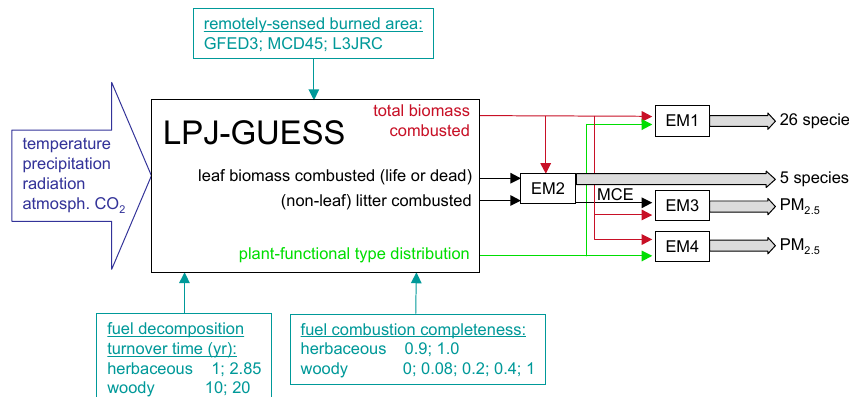
Fig. 1. Flow of information used for the sensitivity analysis (thin arrows) between different models (black rectangles). Fixed inputs to the modified vegetation model LPJ-GUESS in dark blue, variable inputs blue-green, outputs in red, black and green, and emissions shown as grey arrows. MCE: modified combustion efficiency, EM: emission model. CO 2 is global and annual mean, climate inputs gridded and